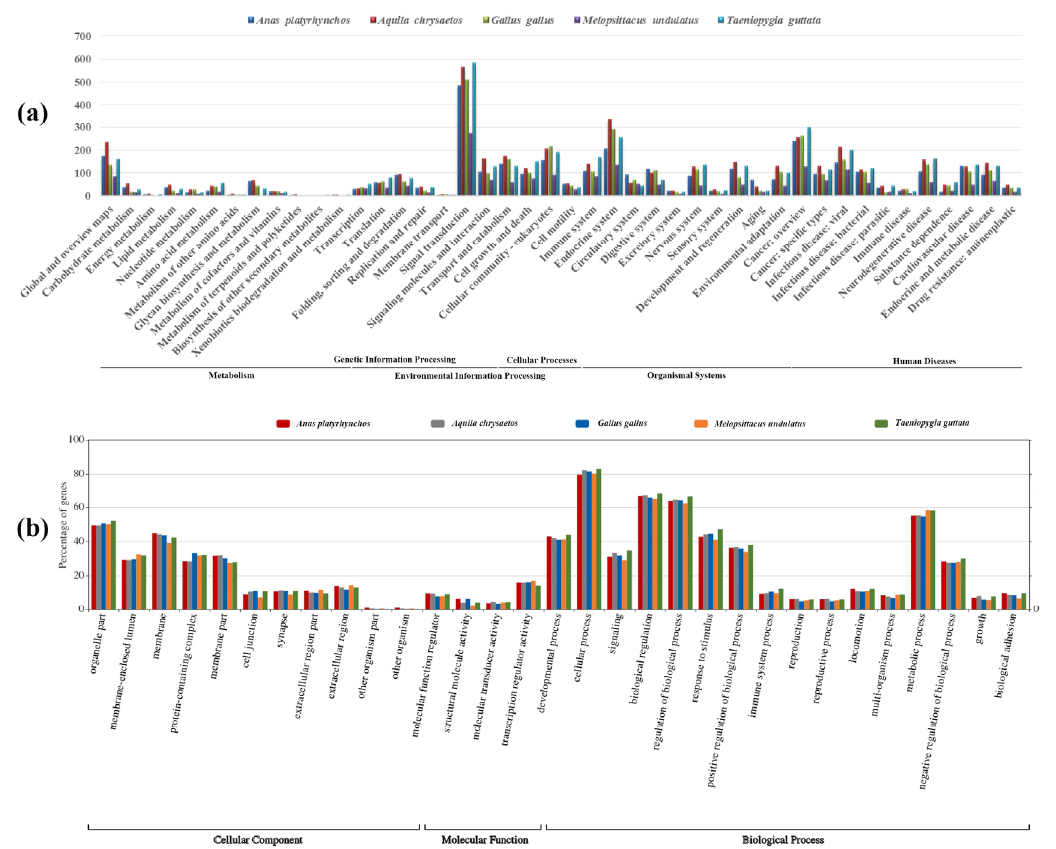
Figure 10. The result of functional annotation for genes contained P-SSRs in coding regions. ( a ) KEGG database ( b ) GO database.